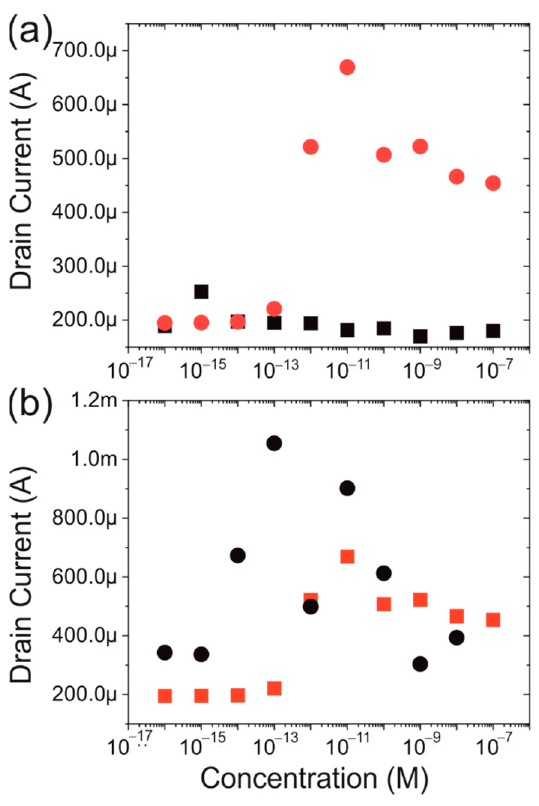
Figure 8. ( a ) comparison between the current at +3 V for BSA (black) and spike protein (red). ( b ) comparison between the current for spike protein in artificial saliva (black) and PBS (red).